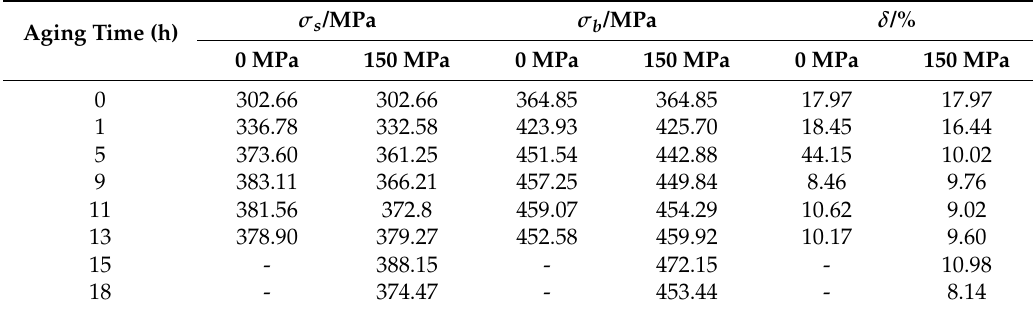
Table 3. Mechanical properties of 2219 aluminum alloy at different aging times under the conditions of 165 ˝ C and 0 MPa/150